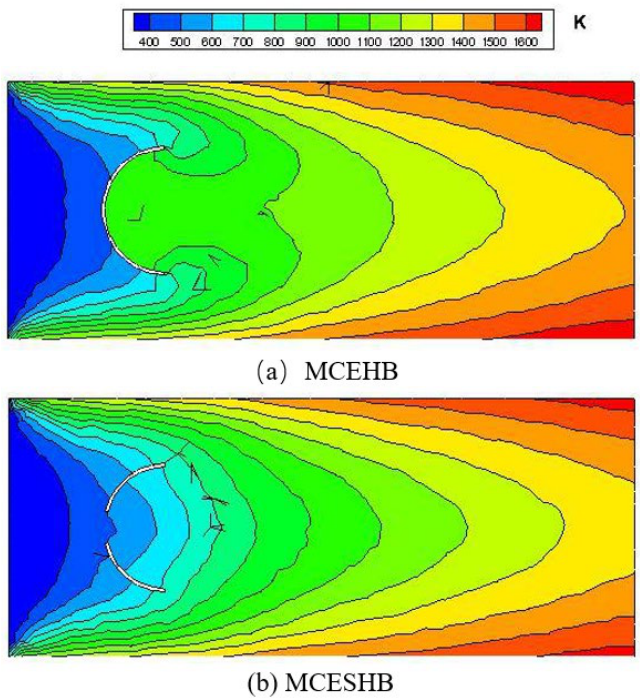
Figure 4. Temperature field distribution in different combustors.